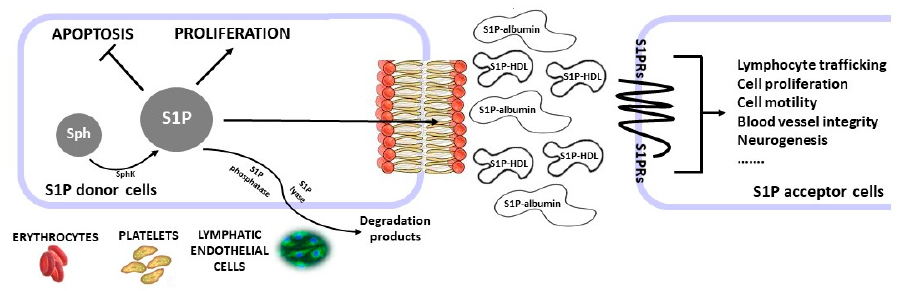
Figure 1. Major signaling pathways and functions of S1P. S1P can act intracellularly to induce either apoptosis or proliferation. S1P can also be exported and can bind S1P receptors in autocrine or paracrine ways. In the circulation, S1P is transported bound to albumin and/or HDL S1P regulates many normal and pathophysiological processes.